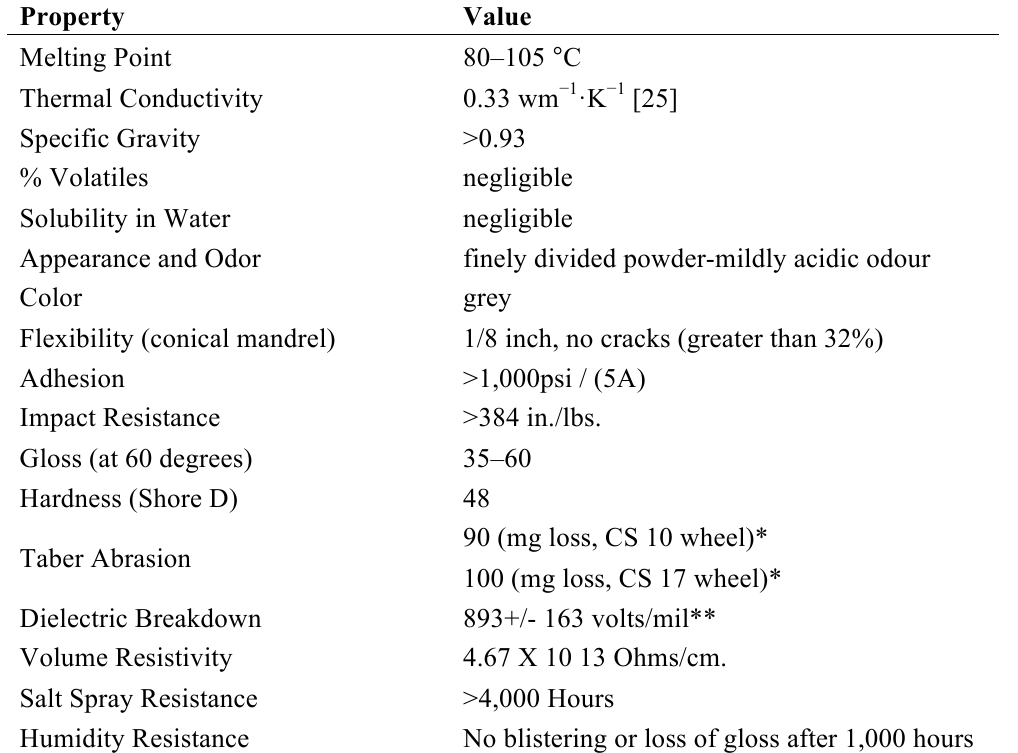
Table 1. Properties of EMAA supplied by Innoteck (TD-Polyarmor G11 data